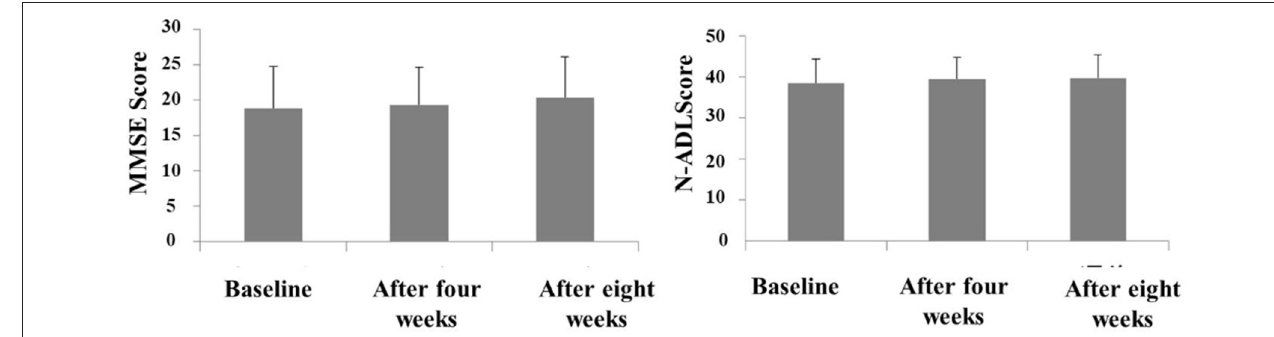
FIGURE 3 | The effects of YKSCH on MMSE and N-ADL. Data were MMSE scores and N-ADL scores (means ± SD and ranges) after YKSCH administration. MMSE results were on 20 cases (12 cases dropped because of missing data), and N-ADL results were on 21 cases (11 cases dropped because of missing data).